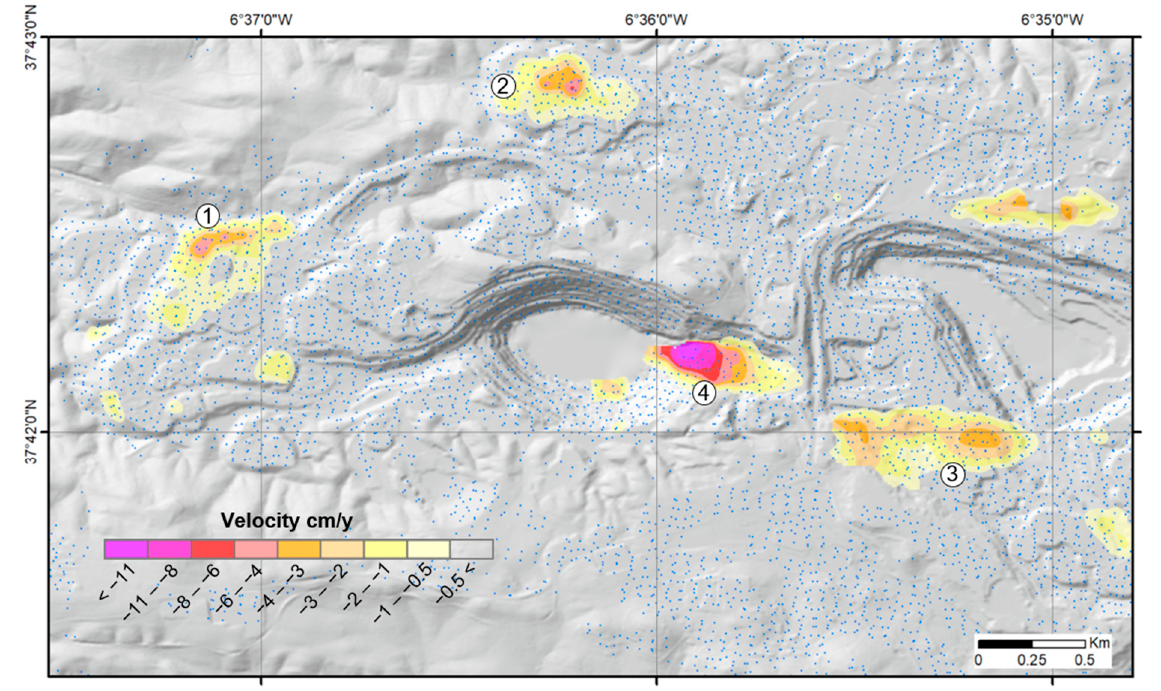
Figure 10. Deformation map showing the velocity anomalies interpolated from the displacement map, blue dots (Figure 8). Negative displacements are downward in flat zones and along the maximum slope in steep zones. The numbers show the four zones under discussion.